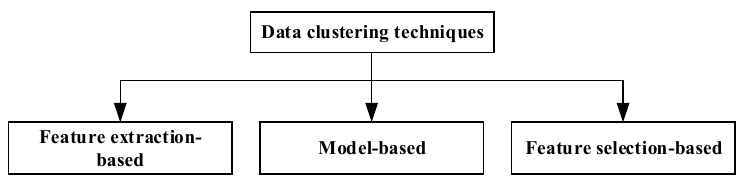
Figure 1. Classification of data clustering techniques for in-network data